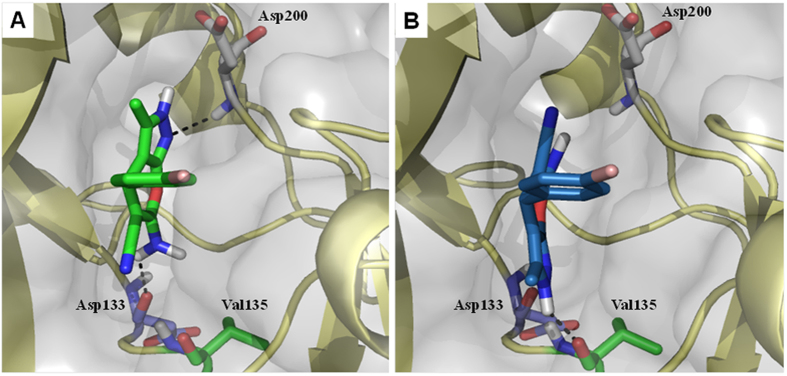
Proposed binding mode of 5m into ATP-binding site of GSK3β.Docking studies of the p-bromo derivative 5m (R enantiomer, green sticks, panel A; S enantiomer, dark blue sticks, panel B) at the ATP binding site of GSK3β.